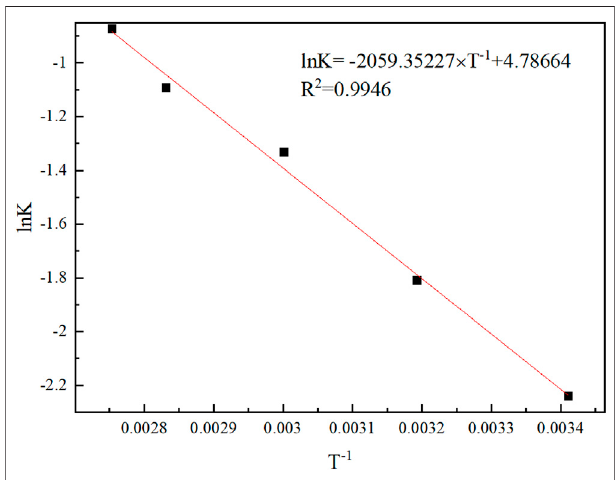
FIGURE 12 | The relation between lnK and